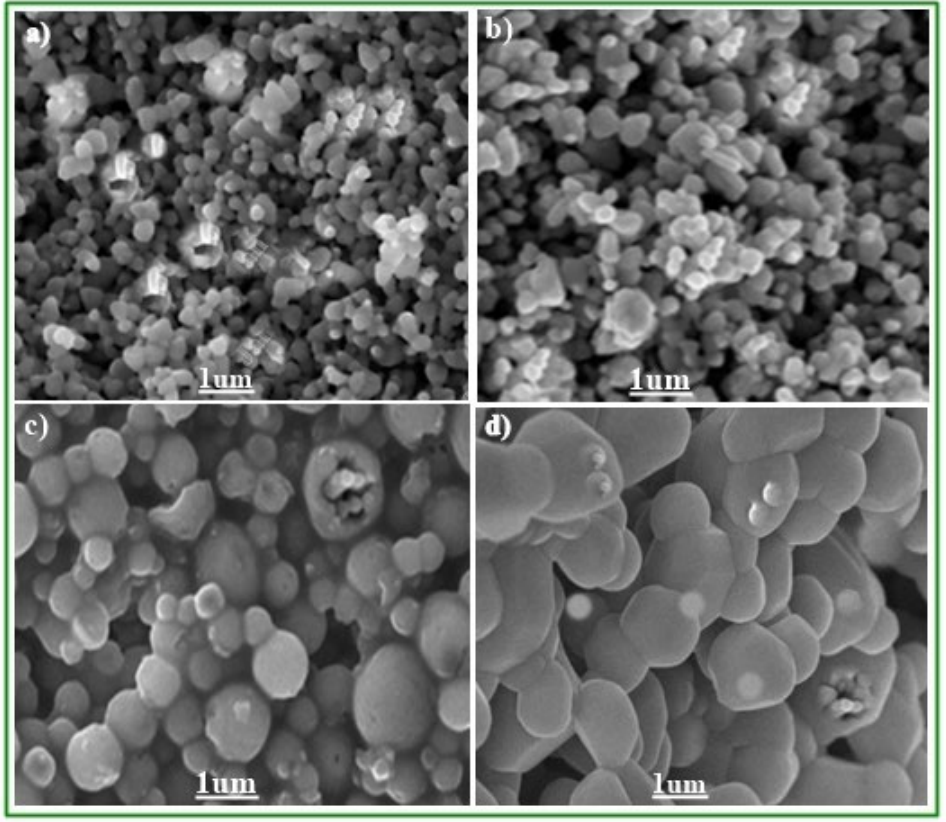
Figure 2. SEM analysis of ZnO nanoparticles to confirm their synthesis and determine their size: ( a ) 1 μm × 5000; ( b ) 1 μm × 10,000; ( c ) 1 μm × 20,000; ( d ) 1 μm × 30,000.